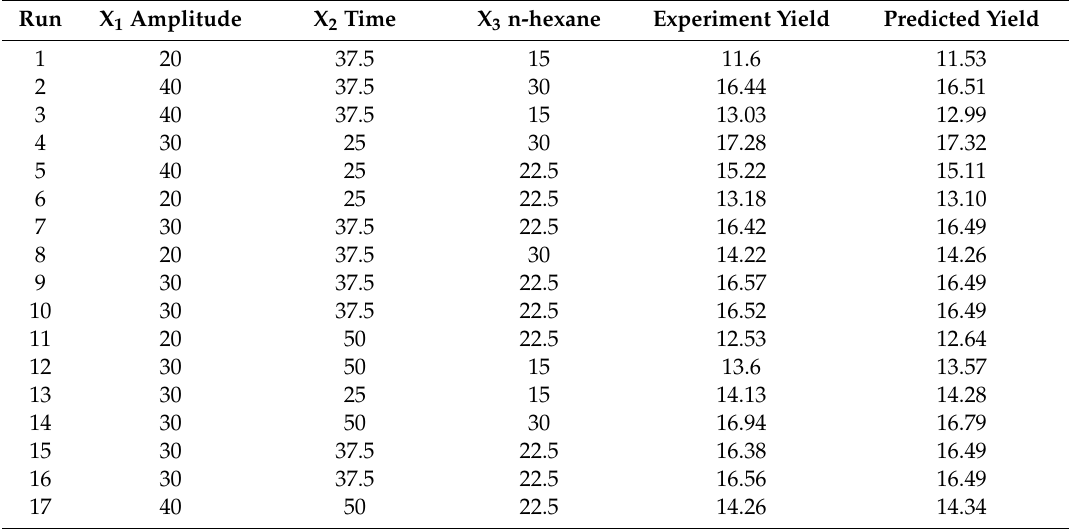
Table 4. Experimental design for the optimisation WCG extraction